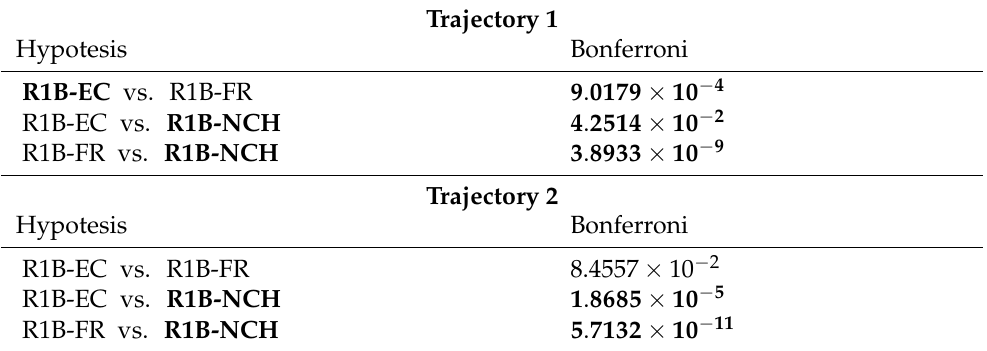
Table 13. p -values for tests in the multiple comparisons among the three outstanding algorithms in study case 2 using both trajectories. R1B-NCH wins two times in both trajectories. R1B-EC wins one time in trajectory 1.